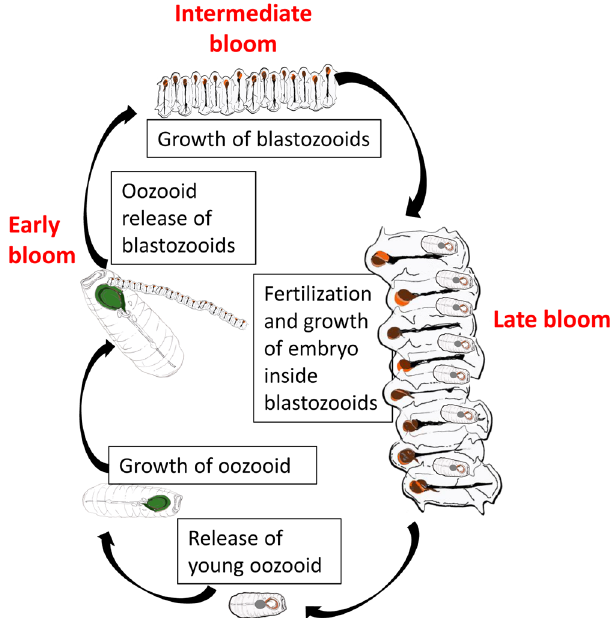
Fig. 3 | Simpli fi ed schematic of the life cycle of salps. The oozooid refers to the asexual (or solitary) stage. The oozooid begins to produce chains of blastozooid clones (also known as the sexual or aggregate phase) typically in response to enhanced phytoplankton biomass, triggering the onset of a bloom. Once blas- tozooids reach maturity they each harbors one oozooid embryo, which is birthed live. After releasing the embryo, the female blastozooids mature their male testis (not shown here), and the cycle is completed with the maturation of the young oozooid.Thelengthoftheentiretyofthecyclefor S.thompsoni inAntarcticwaters ( − 1 – 2°C) has been estimated to range between 2 and 9 months depending on the study,althoughthegenerationtimeoftheblastozooidsismuchshortercompared to oozooids. Growth rates of blastozooids during SalpPOOP suggest a shorter life- cycledurationinthewarmerwaters(~10°C)oftheChathamRise,rangingbetween 12 and 42 days (average 23). The blastozooids emerge as <1mm sized animals and continue to grow to ~50mm when mature